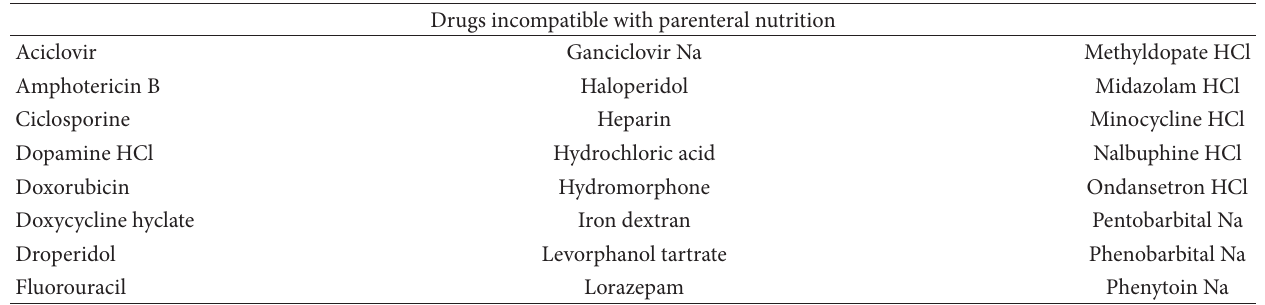
Table 5: Examples of drugs incompatible with parenteral nutrition [39].